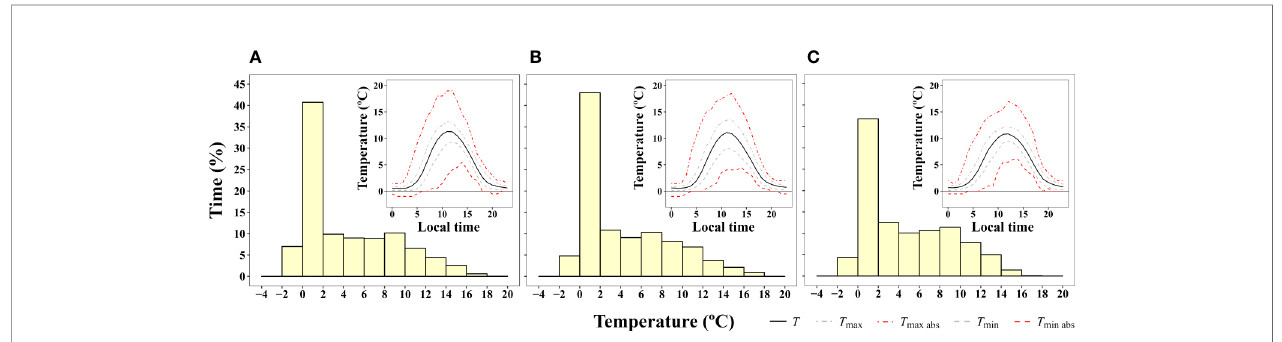
FIGURE 3 | Frequency of time (% of hours) during which a certain two degree interval of surface temperature was experienced by (A) B. pseudotriquetrum , (B) C. purpureus , and (C) S. antarctici averaged over 13 days during the 2003 summer season (from 16/01/2003 to 28/01/2003). Moss temperature was recorded with iBcod sensors placed in moss beds at six locations within 100 m of Casey Station. Inset graph shows diurnal course of surface